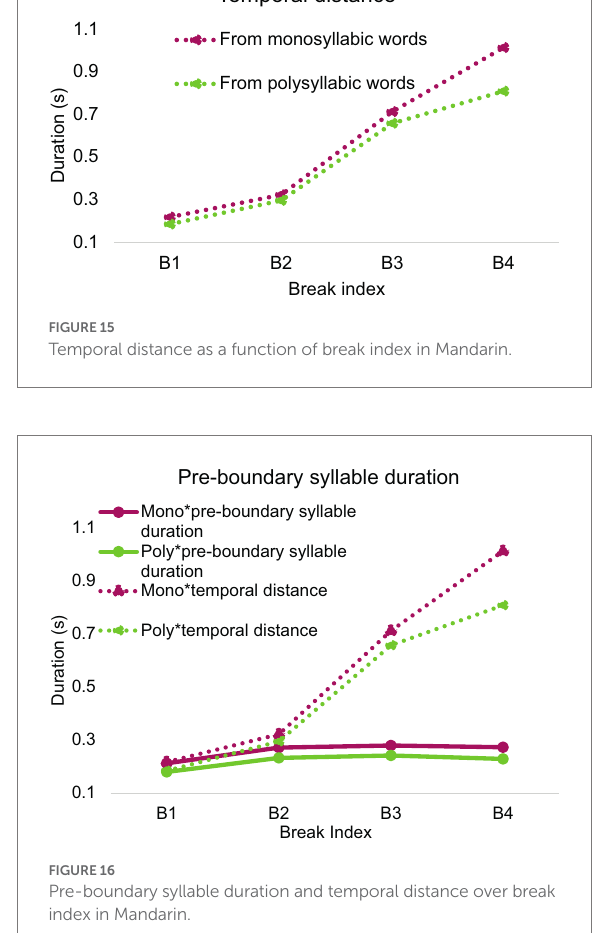
TABLE 3 Results of repeated measures ANOVAs on the effect of break index on pre-boundary syllable duration and temporal